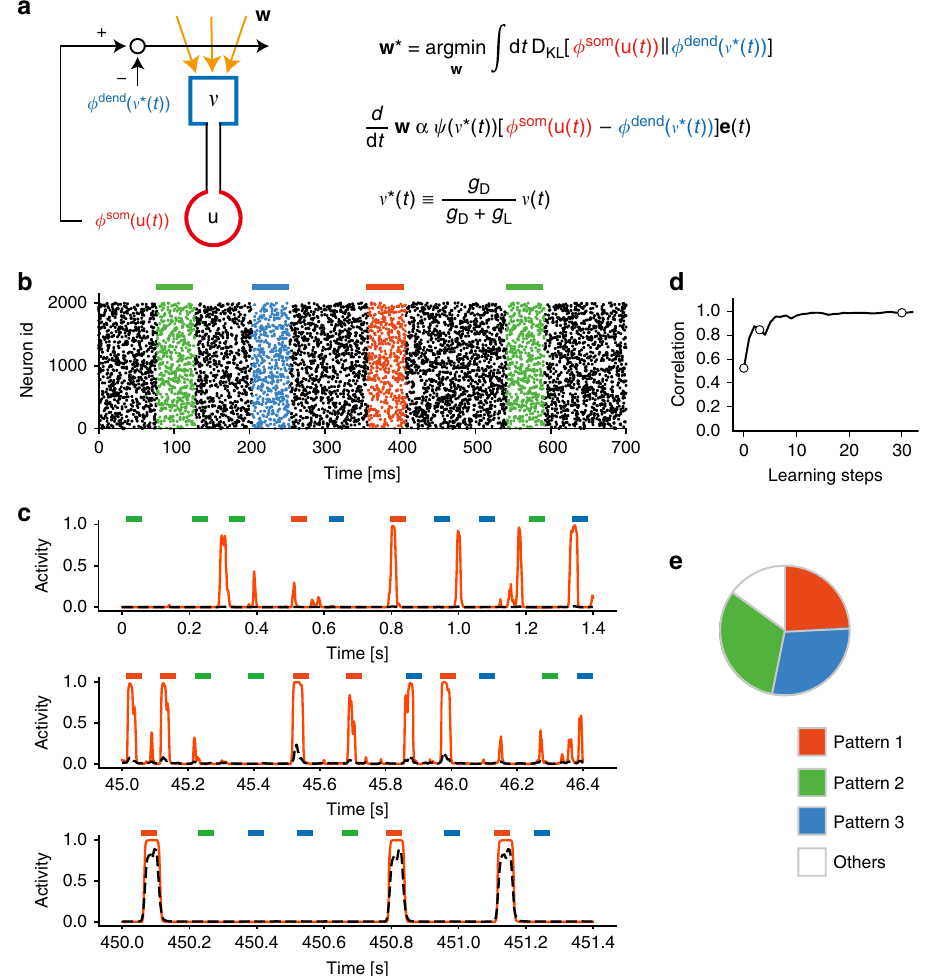
Fig. 1 Unsupervised learning in two-compartment neurons. a The model neuron consists of somatic and dendritic compartments and undergoes MRIL learning. The dendritic component receives Poisson spike trains, and the somatic membrane potential is given as an attenuated version of the dendritic membrane potential. Output of the soma backpropagates to dendritic synapses as a self-teaching signal. Learning stops when the dendrite minimizes the error between its prediction and the actual somatic fi ring rate. b Three frozen spatiotemporal patterns (red, blue, and green) were repeated in irregular spike trains from 2000 input neurons. c A two-compartment neuron selectively learned one of the recurring patterns. Examples of the somatic (red) and dendritic (black dashed lines) activities are shown at the initial (top), middle (middle), and fi nal (bottom) stages of learning. d Learning curve is shown, with circles indicating the time points at which the examples were drawn. Instantaneous correlations were calculated between the activities of the dendrite and soma every 15 s during learning. e The fraction of trials in which a single neuron model learned a selective response to one of the three repeated spike patterns is shown. The number of trials was 100. In some trials (Others), the neuron had more than one preferred pattern, i.e., the peak response to the second preferred pattern was greater than 50% of that to the most preferred